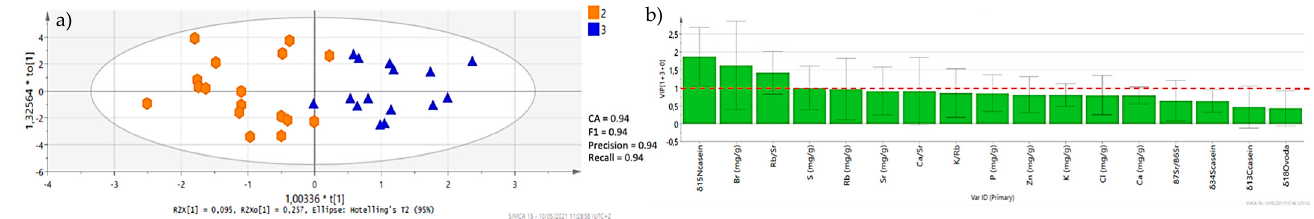
Figure 7. OPLS-DA score plots and VIP values in the pairwise comparison between three different geological regions derived from all isotopic and elemental composition data of milk samples. ( a ) The ellipse on the score plot represents the 95% confidence interval. ( b ) The red-dotted line indicates criteria used to identify the variables for model development.